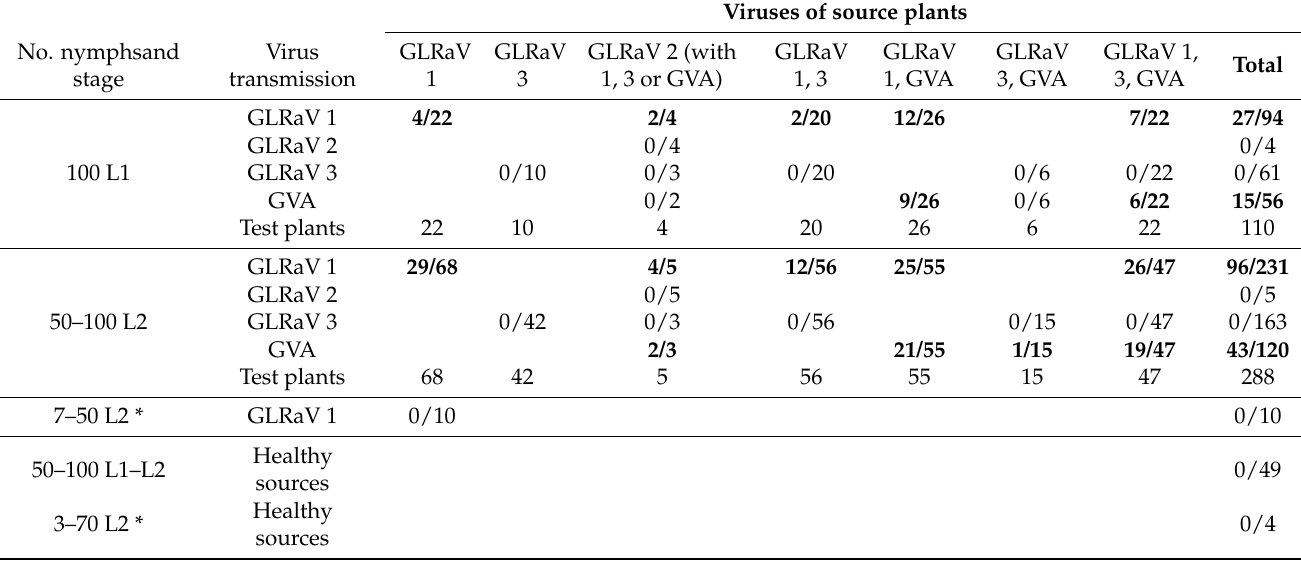
Table 4. Virus transmission rates by vineyard-collected Parthenolecanium corni nymphs according to their developmental instar and to virus associations in plant source, after transmission tests: number of positive vines/number of inoculated vines. Transmission events are highlighted in bold. Overwintering L2 are marked with an